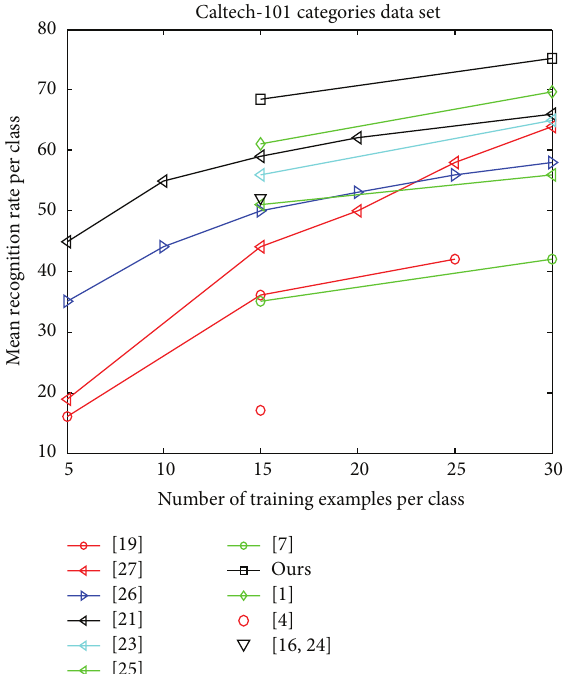
Figure 3: Comparison against existing techniques on the Caltech-101.